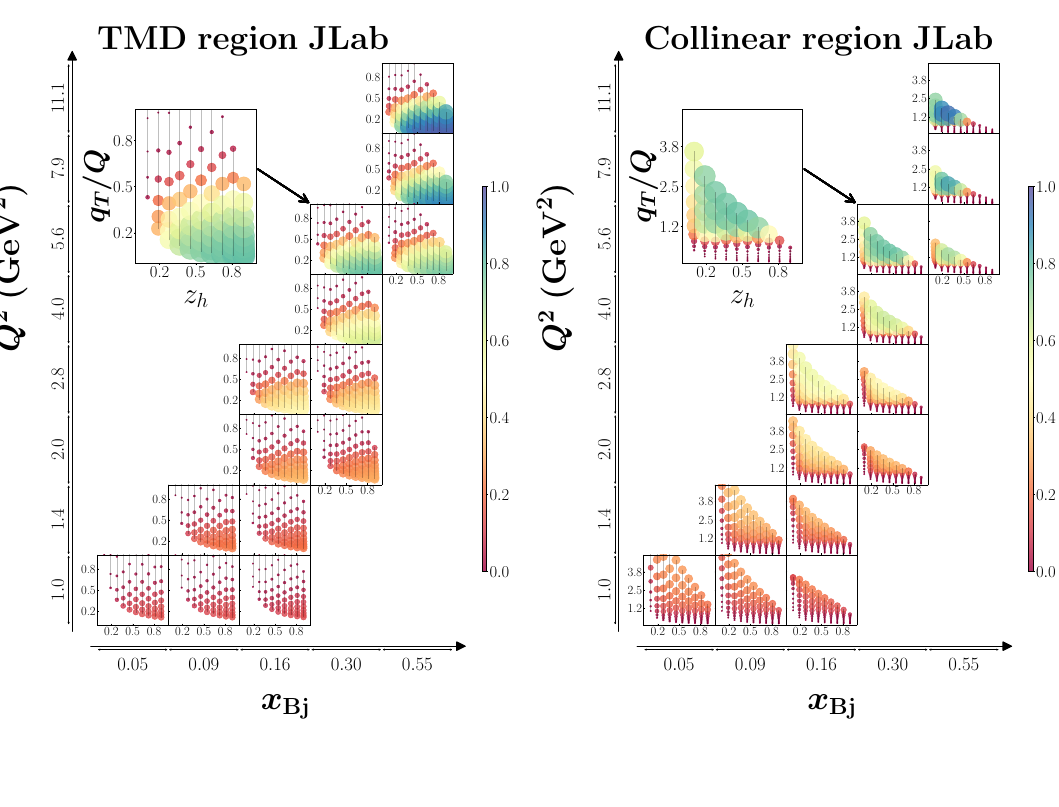
Figure 12 . Affinity to the TMD and collinear regions at Jefferson Lab